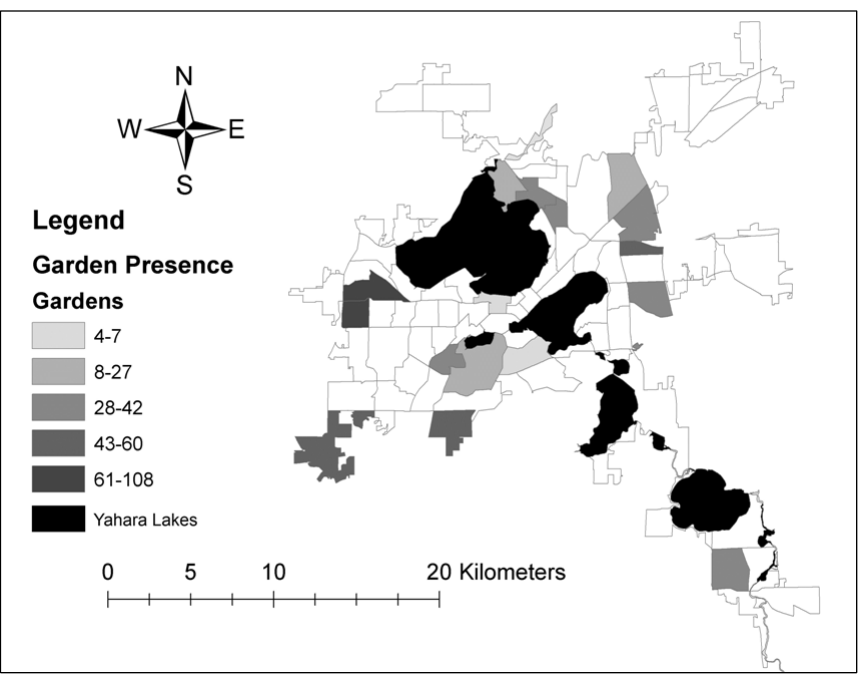
Figure 4. Sampled Home Garden Presence Total number of sampled home gardens tends to increase with distance from urban center.